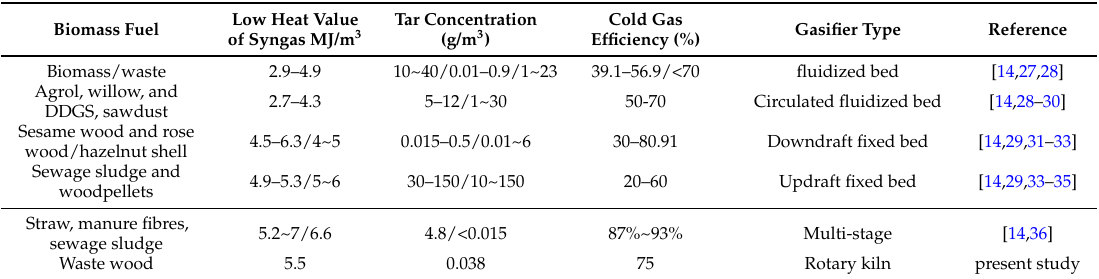
Table 4. Comparison of the experimental results with published in